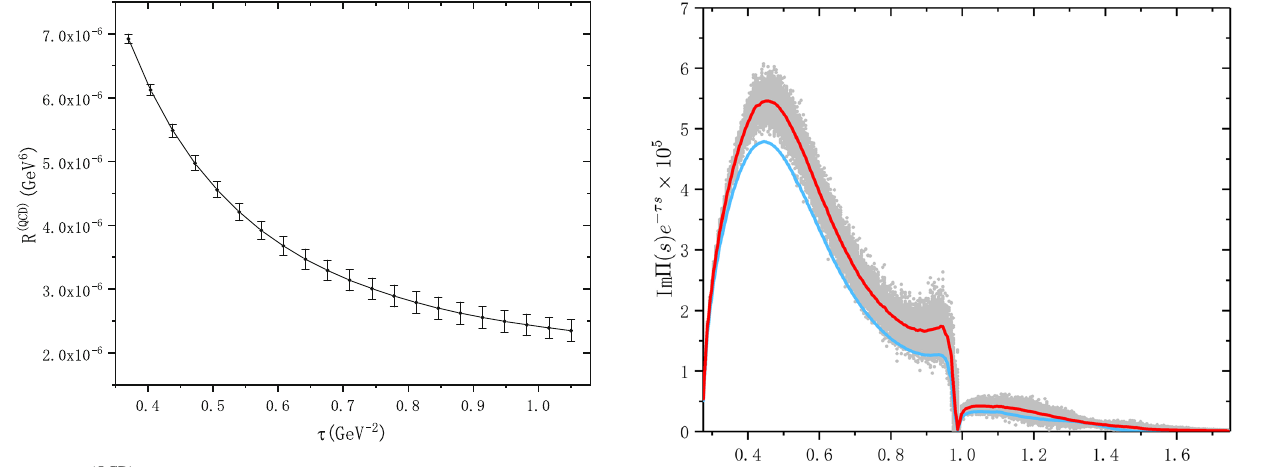
Fig. 1 R (QCD) in Eq. (4), together with its uncertainties σ (τ ) in Eq. (26), as functions of the Borel parame- j = 1 , 2 ,..., 21 QCD ter τ . See the text for details about the estimation of the uncertainty σ QCD